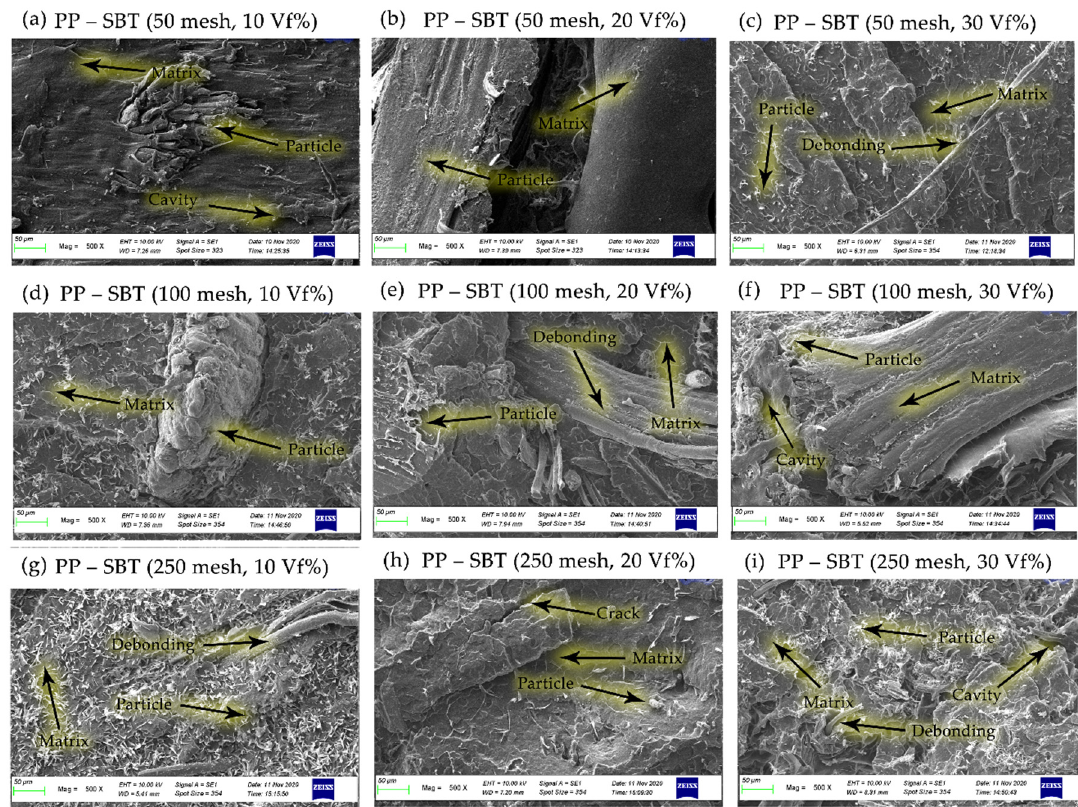
Figure 16. SEM micrographs on the morphology of the PP–SBT composites. Cracks are usually seen when there is a strong bond between the fiber and the matrix; when the fiber is pulled due to stress transfer, then the matrix around the fiber becomes cracked. The same phenomenon has been described by Khan et al. [44] in their work on the fiber-matrix debonding at the interface and by Johnson et al. [53] in their work on the roles of the matrix cracking and fiber-matrix debonding on stress transfer between the fiber and the matrix in single fiber fragmentation assays. Johnson et al. [53] adhere to this matrix by a strong interface between the fibers and the matrix resulting in transverse cracking of the matrix. Figure 17 shows a path that has been blocked or deflected by the presence of fiber. Crack pinning or crack path deflection is the same phenomenon as described by [54,55] during their work on flax fiber composites, where they observed the deflection or crack path change with changes in fiber orientation and fiber volume fraction.